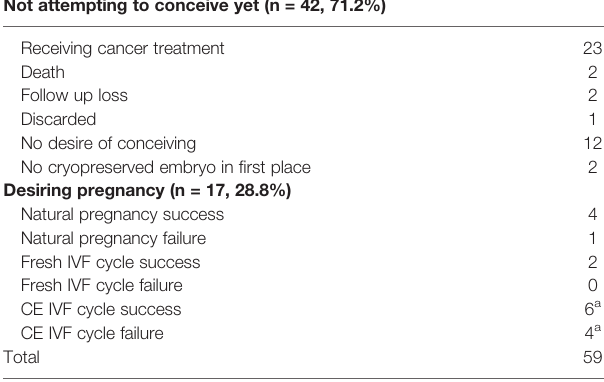
TABLE 2 | Current status of patients who underwent oocyte cryopreservation and its utilization. Not attempting to conceive yet (n = 316, 88.5%)